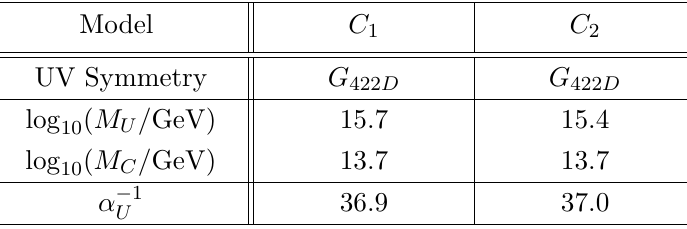
Table 6 . The predictions of models C 1 and C 2